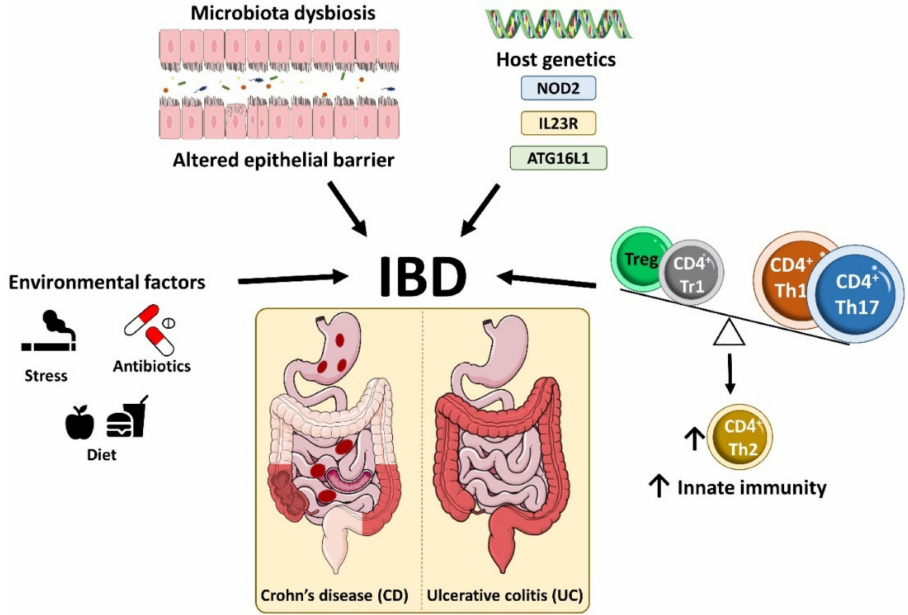
Figure 1. Etiology of inflammatory bowel disease. IBD is a heterogeneous state of chronic intestinal inflammation comprising two main clinical phenotypes, Crohn’s disease (CD) and ulcerative colitis (UC), which are distinguished by their symptoms, disease location and histopathological features. IBD arises from the interplay between environment factors, the gut microbiota and immunological factors in genetically susceptible individuals, which promotes intestinal barrier dysfunction, tissue damage and dysregulated innate and adaptive immune